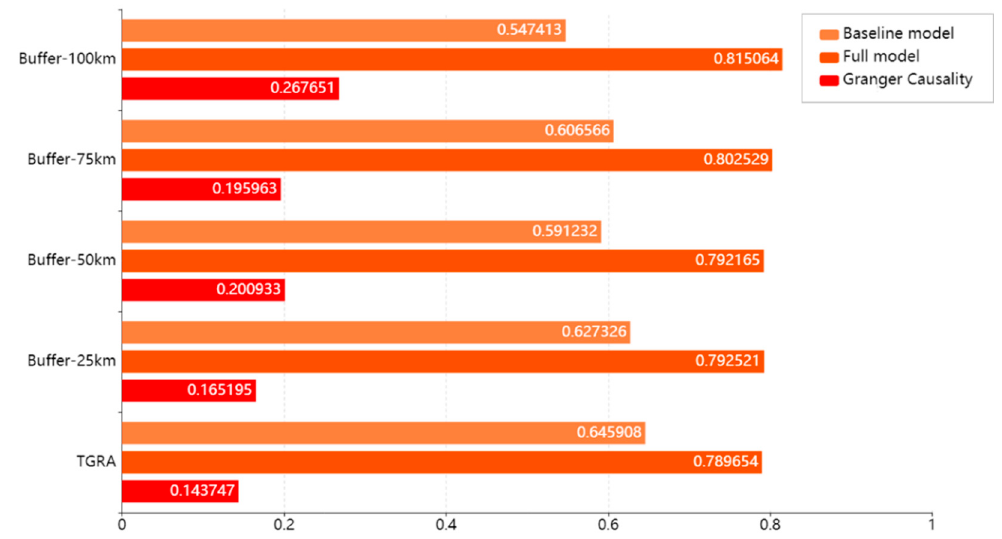
Figure 4. Feedbacks of vegetation dynamics with respect to the cumulative sum of 20 days’ water level.